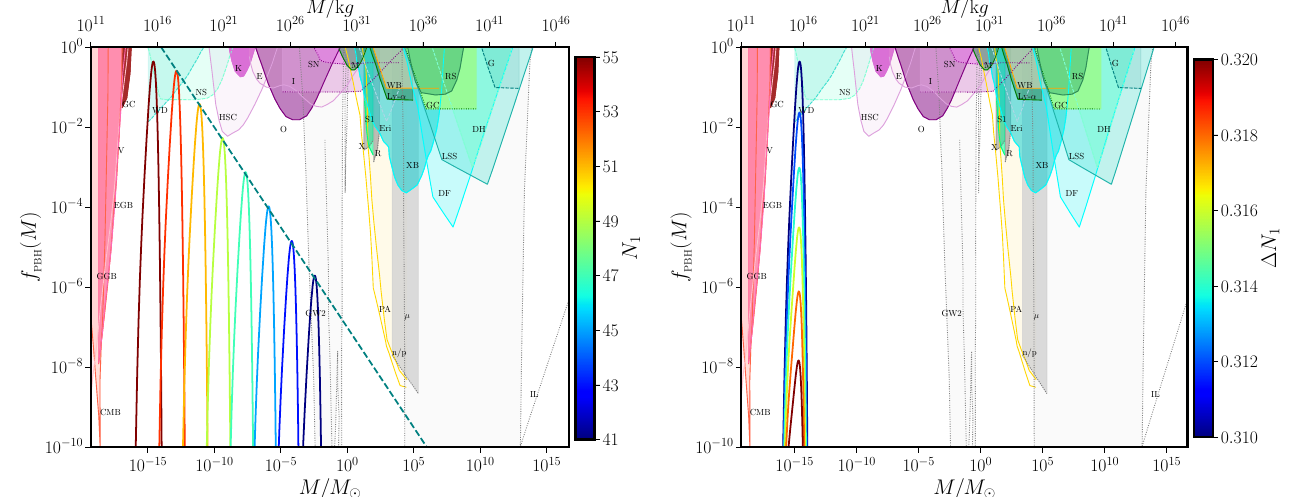
( M ) that arises in the reconstructed scenario has been plotted for different Figure 8. The quantity f PBH ( M ) values of N 1 (on the left ) and ∆ N 1 (on the right ). As N 1 is varied, we find that the peaks of f PBH behave as M − 1/2 (indicated in dashed teal) for reasons explained in the text. The increase in ∆ N 1 , with a fixed value of N 1 = 41, results in drastic reduction in the amplitude of f (as shown in PBH the figure on the right). This can be attributed to the fact that an increase in ∆ N 1 leads to a gentler transition from slow roll to ultra slow roll inflation, and hence to a smaller height of the peak in the power spectrum. We have also included the constraints from the different observations, as in ( M ) depends exponentially on the amplitude of the the previous figure. Note that the quantity f PBH scalar power spectrum. Hence, despite the wide peaks in the scalar power spectra (cf. Figure 5), the ( M ) proves to be rather narrow. Due to this reason, we believe that the constraints for shape of f PBH the monochromatic power spectra (which we have indicated in the figure) also apply well to the situations of our